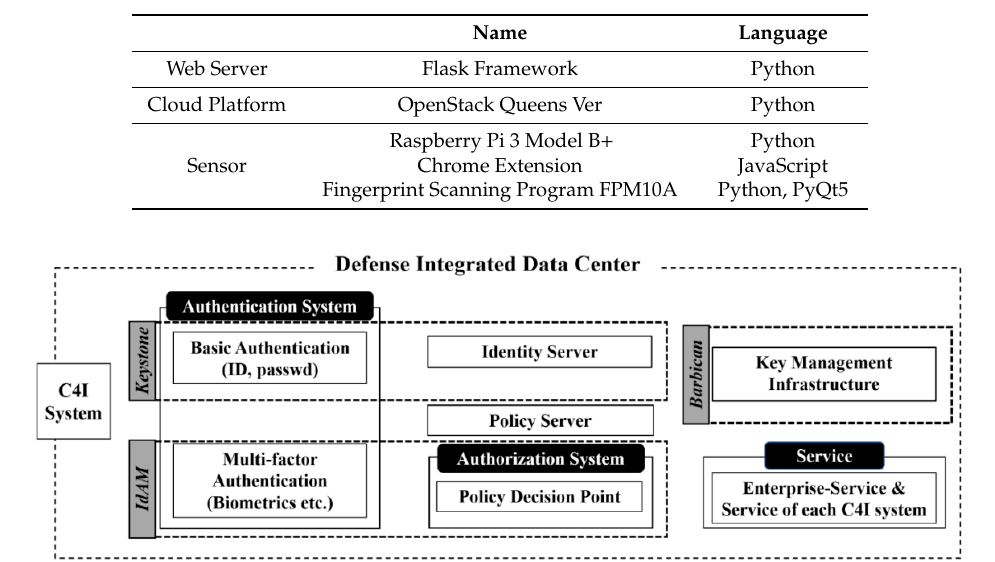
Table 3. Test Environment and Configuration.